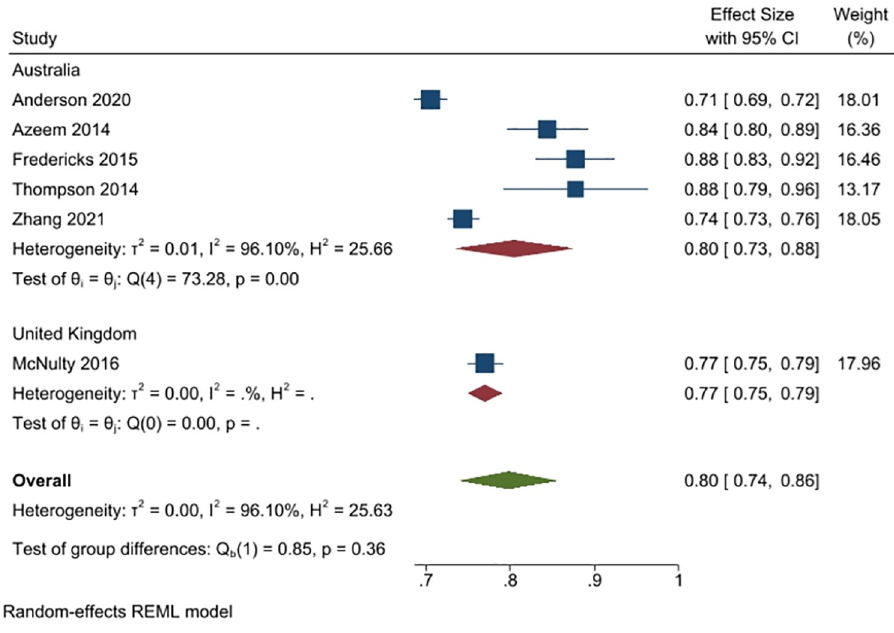
Fig 6. Percentage of respondents answering yes to the question whether antibiotics are useful or effective for treating bacterial infections.